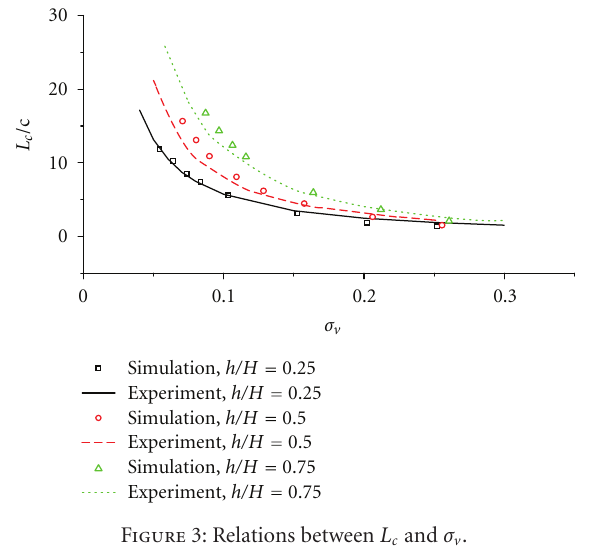
Figure 3: Relations between L c and σ v .